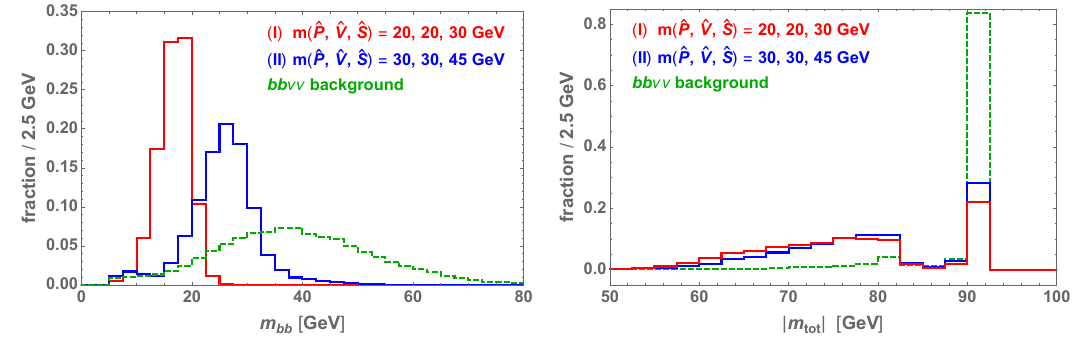
Figure 8 . Normalized distributions of the b (cid:22) b invariant mass ( left ) and absolute value of m tot ( right ) for the Z ! ^ P ^ S ! b (cid:22) b(cid:23)(cid:23) + X signal and the irreducible b (cid:22) b(cid:23)(cid:23) background at a Z factory, after the basic selection that requires two b -tagged